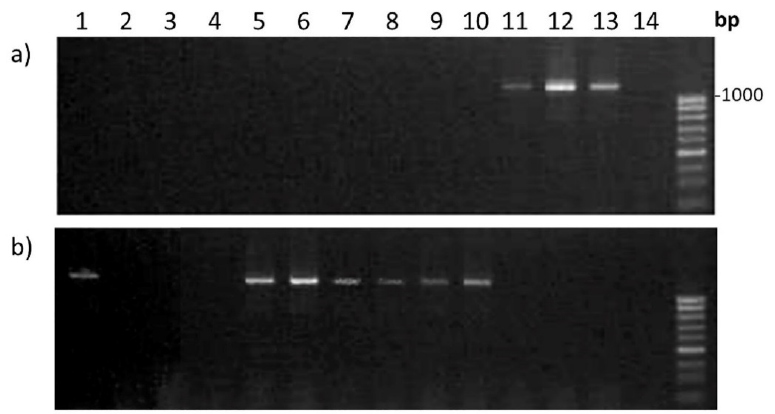
Figure 7. PCR amplification with primers B1for/Znfrev ( a ) and b1for/Znfrev ( b ). The first pair marks the awnless forms with the dominant B1 gene, the second pair marks the awned forms with the recessive b1 gene. Samples: 1— T. aesti vum Chinese Spring; 2–4—triticale; 5–7—hybrid Line 808/1; the recessive b1 gene. Samples: 1— T. aestivum Chinese Spring; 2–4—triticale; 5–7—hybrid Line 808/1; 8–10—hybrid Line 844/4; 11–13—hybrid Line 857; and 14— S. cereale . 8–10—hybrid Line 844/4; 11–13—hybrid Line 857; and 14— S. cereale